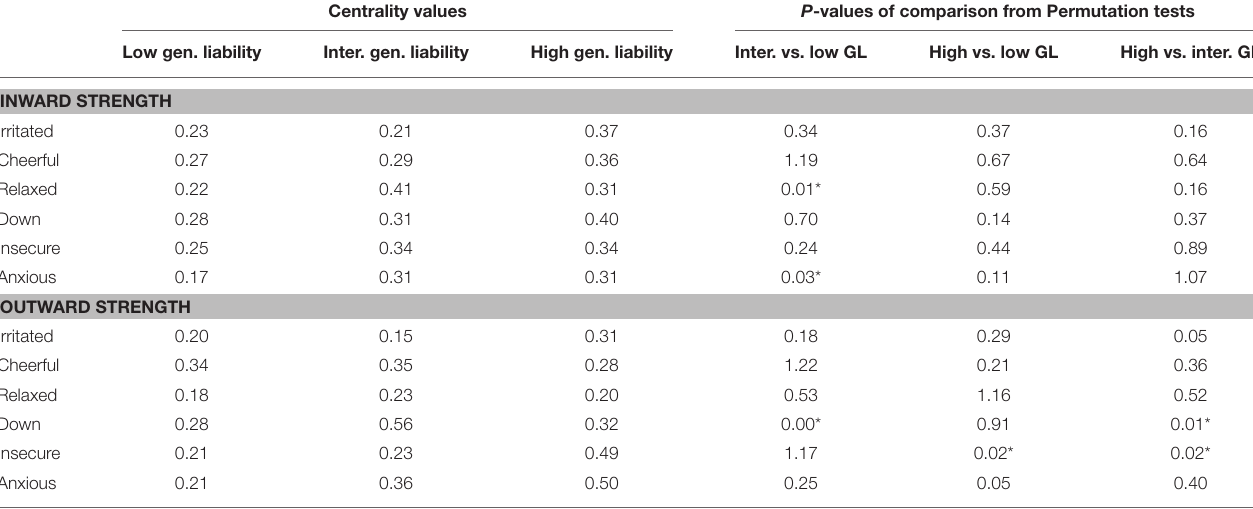
TABLE 4 | Node strength centrality indices and their relation to genetic liability to psychopathology. Centrality values P -values of comparison from Permutation tests Low gen. liability